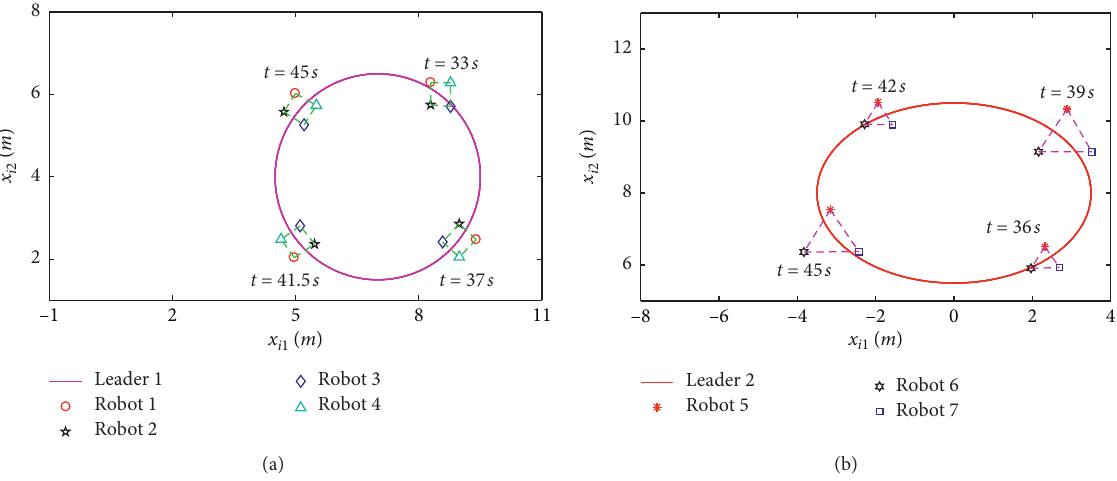
Figure 14: Tracking trajectories of the first subnetwork (a) and the second subnetwork (b) in the XY